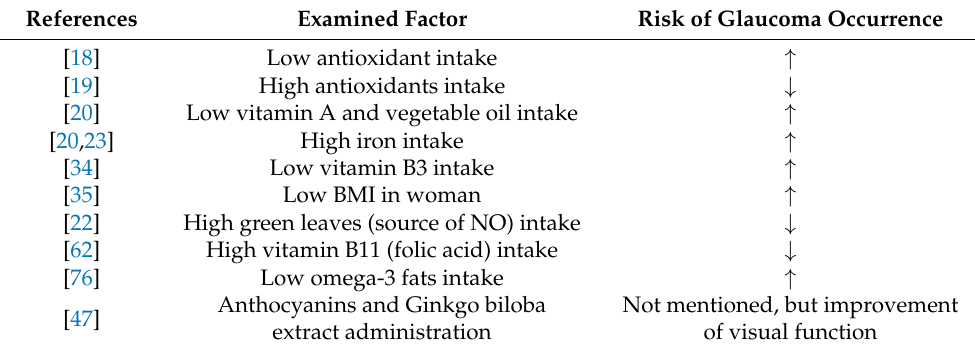
Figure 1. Flowchart showing proposed approach. Table 1. Selected diet components intake and risk of glaucoma